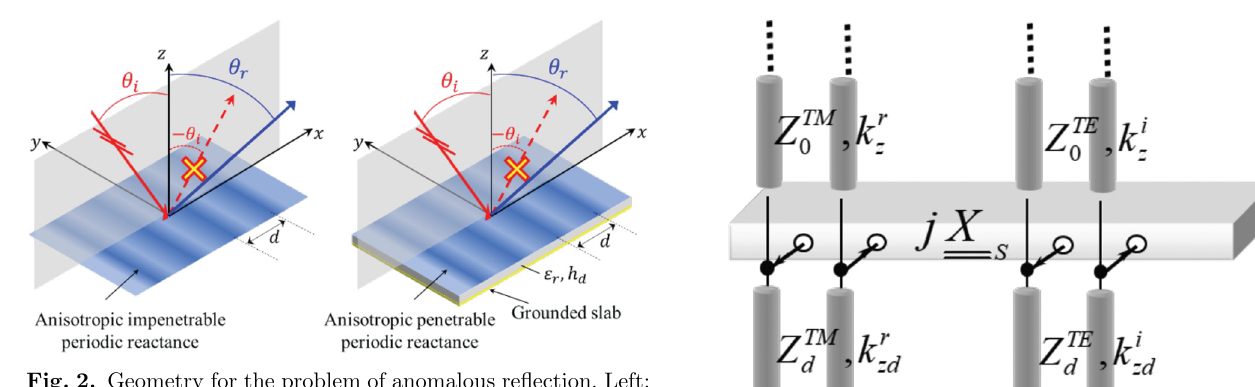
Fig. 2. Geometry for the problem of anomalous re fl ection. Left: impenetrable reactance. Right: penetrable reactance on a grounded dielectric slab.